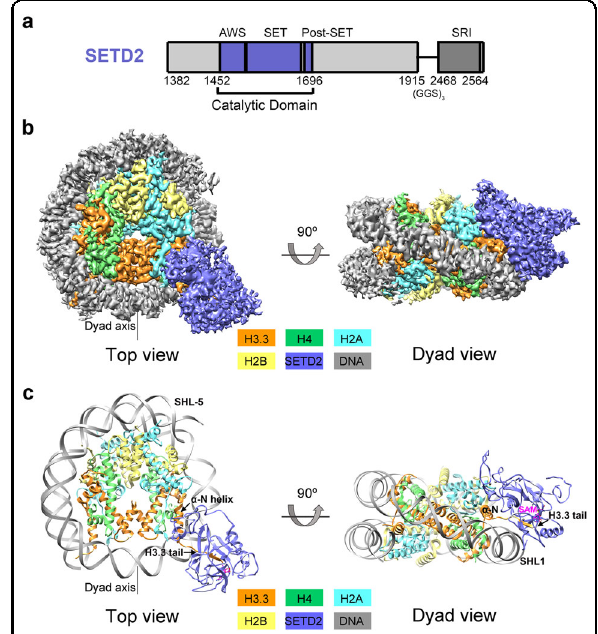
Fig. 1 Overview of the human SETD2 – hNCP H3.3K36M complex structure. a Schematic drawing of the domain organizations of human SETD2. The color scheme is the same as that of the SETD2 – hNCP H3.3K36M structural model. b Cryo-EM density map of human SETD2 – hNCP H3.3K36M complex at 3.1 Å shown from two